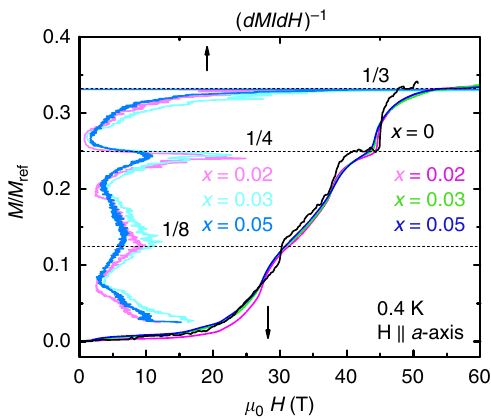
Fig. 2 Magnetization normalized by the reference magnetization M ref . M/ M ref vs. µ 0 H (bottom axis) for x = 0 (black), 0.02 (magenta), 0.03 (green), and 0.05 (blue), with H ∥ a -axis, at T = 0.4 K. Plateaus are indicated by peaks in the inverse susceptibility ( dM / dH ) − 1 (top axis) for x = 0.02 (light magenta), 0.03 (light cyan), and 0.05 (light blue). Dashed lines guide the eye. The magnetization values at the 1/3 (pseudo-1/ n ) plateau are used to extract the reference saturation magnetization, M ref = 1.065, 0.952, 0.913, and 0.881 µ B per Cu for the x = 0, x = 0.02, x = 0.03, and x = 0.05 samples, respectively. Here, the x = 0 trace (black) of M vs. µ 0 H is reproduced from a H ∥ c -axis trace (adapted with permission from, ref. 24